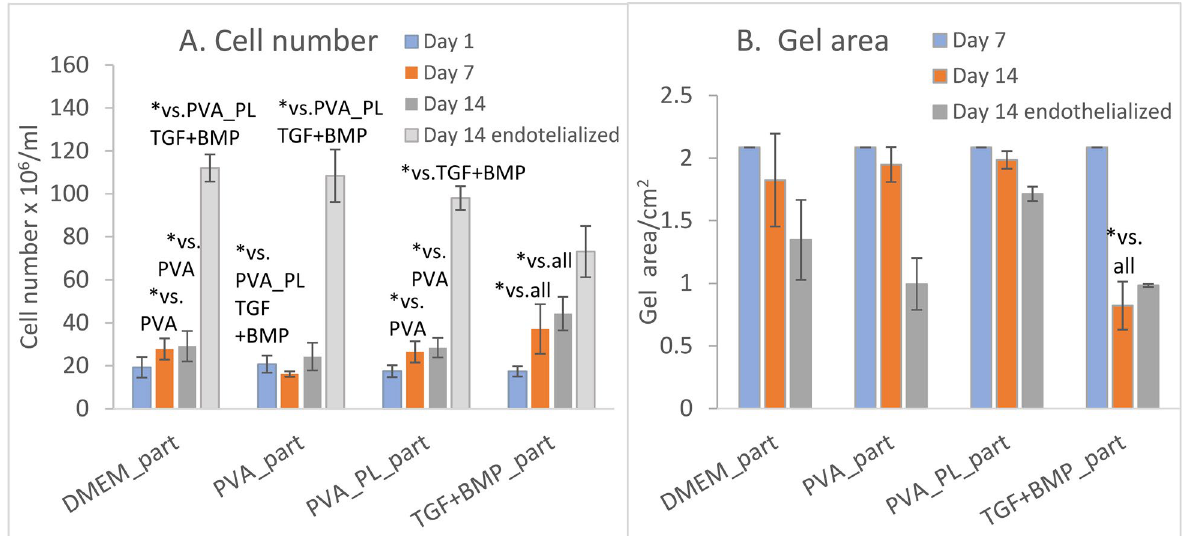
Figure 7. ( A ) Densities of ASCs cultured in collagen gels with particles on days 1, 7, and 14, and density of both ASCs and ECs in endothelialised gels on day 14; ( B ) gel area. Data are expressed as mean ± S.D. Statistical significance is considered * for p -value < 0.05.